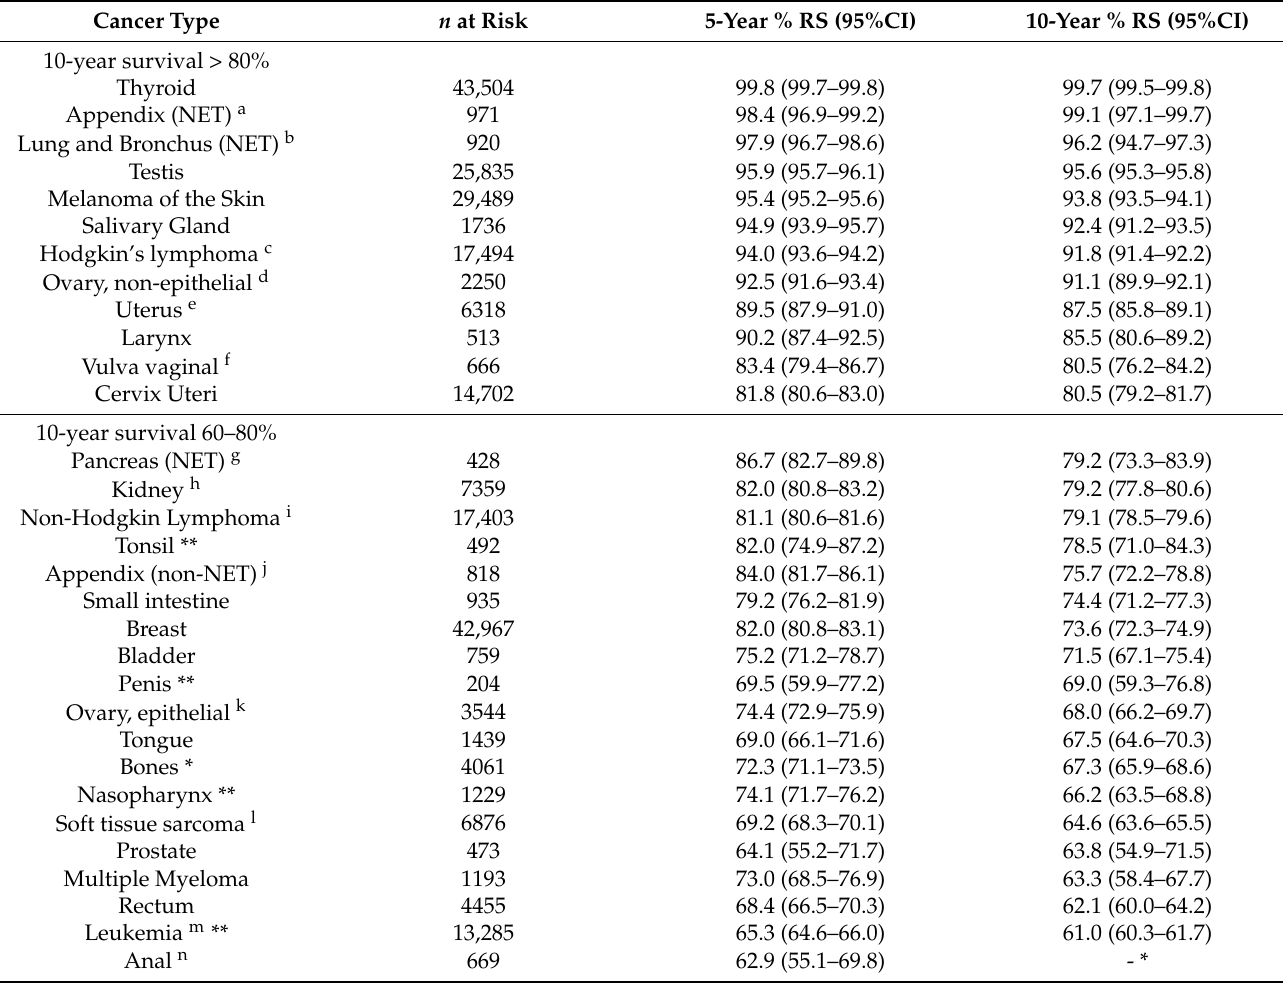
Table 1. Age-standardized 5- and 10-year relative survival (RS) by primary cancer type in adolescents and young adults diagnosed between 1998 and 2016 (SEER 18, Regs Research Data, Nov 2018 submission) in rank order of 10-year RS. Cancer